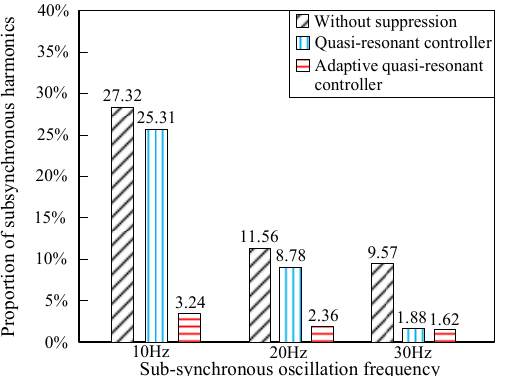
Figure 22. The results of the FFT spectrum analysis of the DFIG stator current.